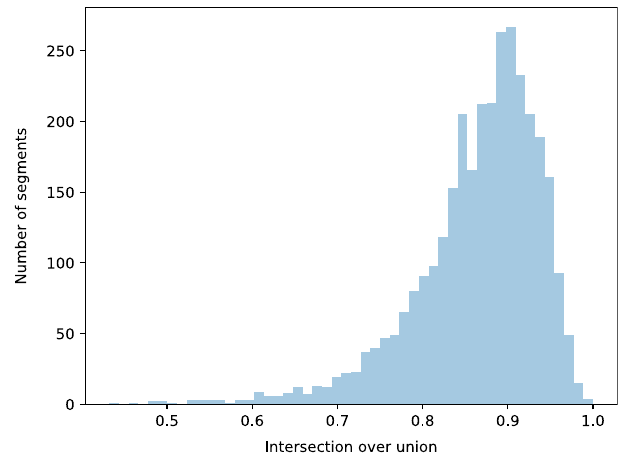
Figure 2. Normalized intersection area between manual and predicted